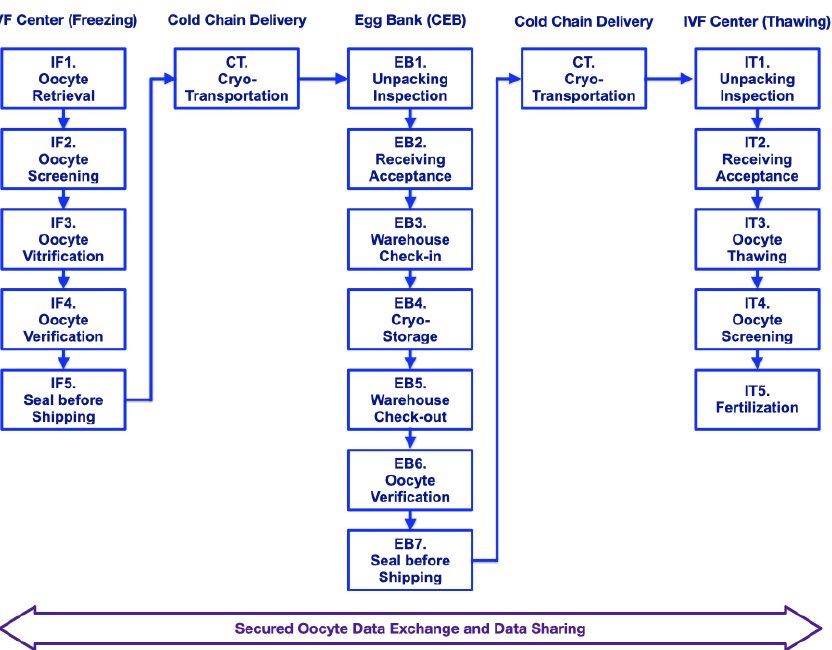
Figure 5. A typical egg banking workflow from oocyte retrieval to